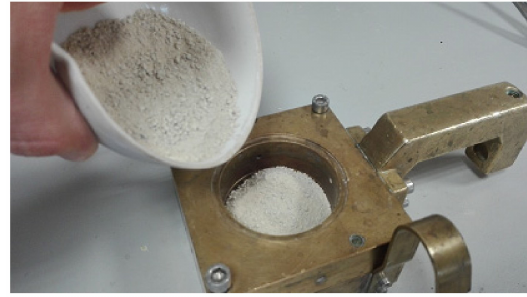
Figure 5. Pouring the sand into the box.